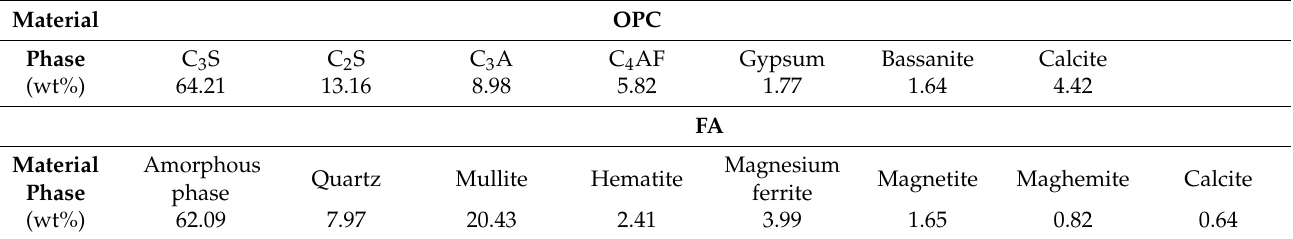
Table 2. OPC and FA quantitative mineralogical composition (wt%).